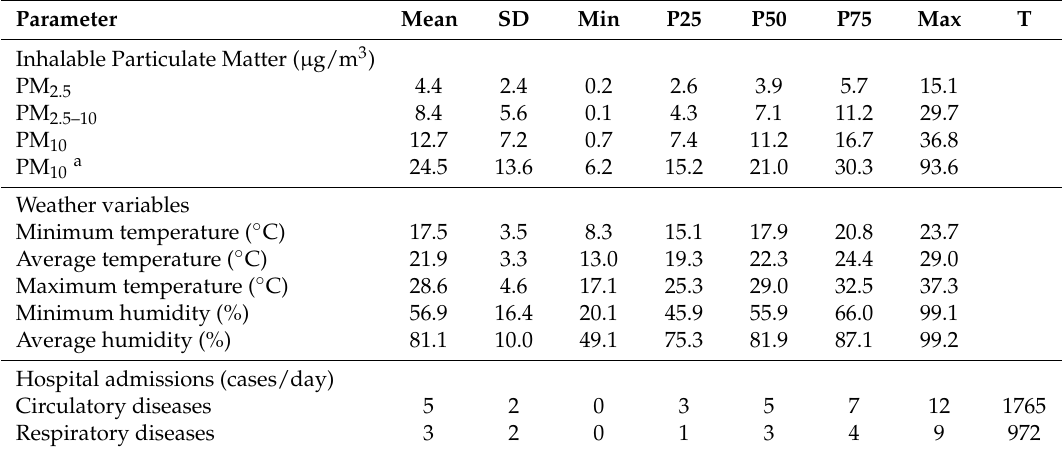
Table 1. Descriptive statistics of pollutants, weather variables and hospital admissions, São José dos Campos, Brazil,